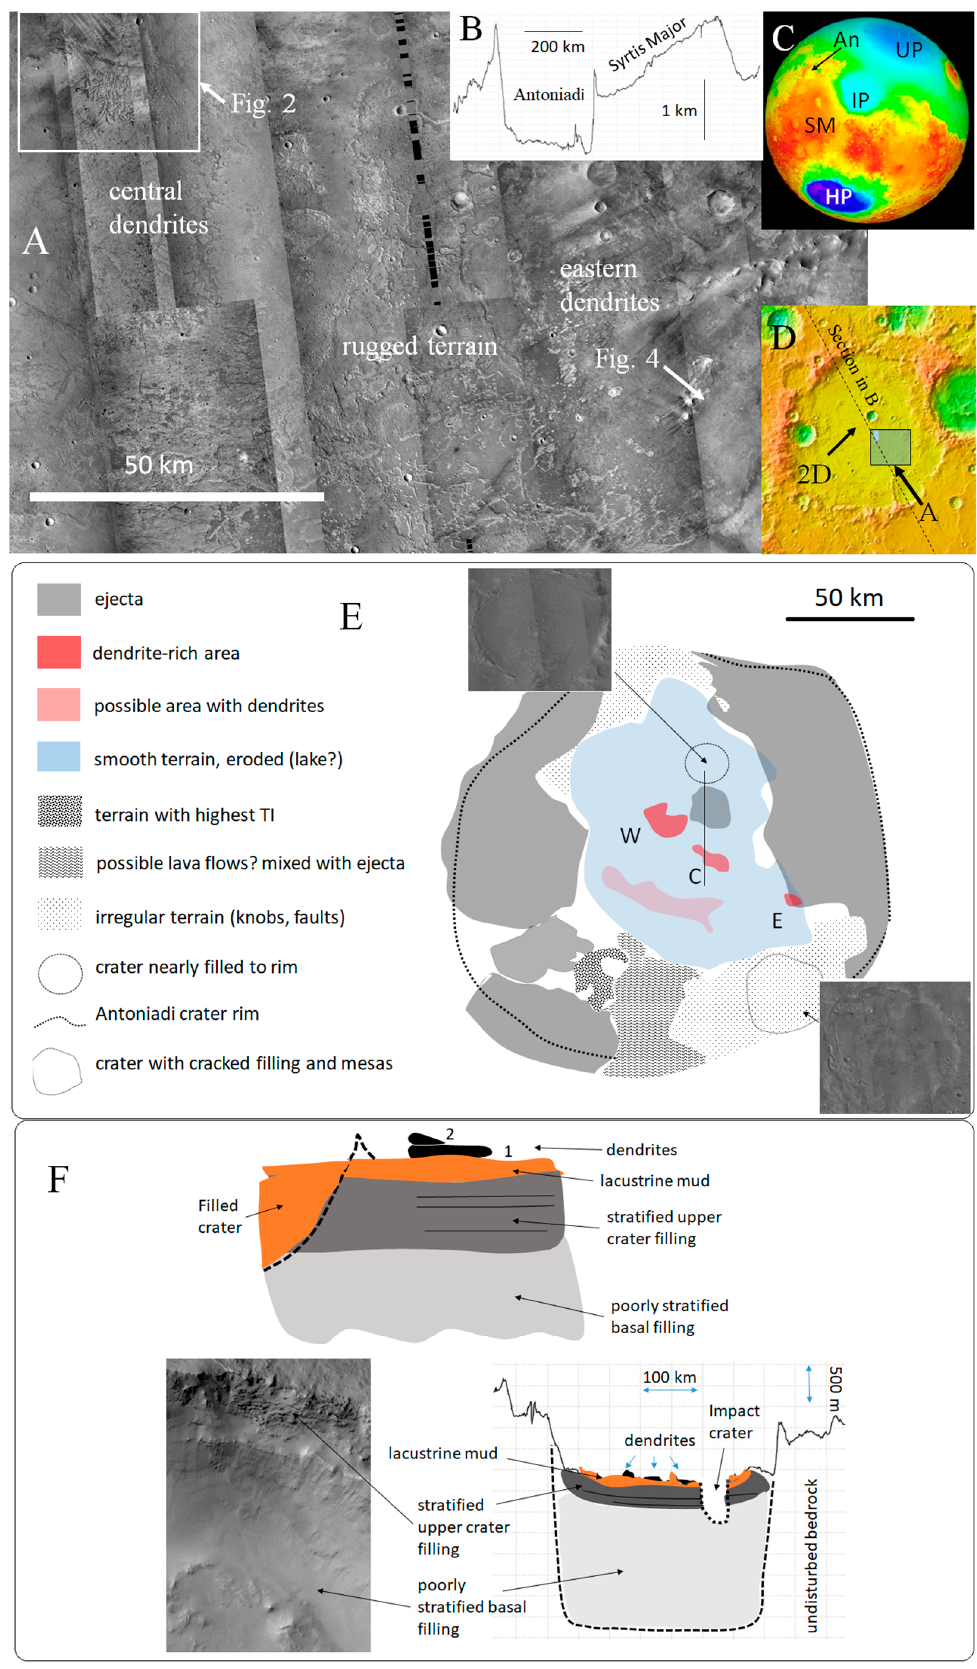
Figure 1. The Antoniadi crater. ( A ) The roughness of the crater floor is evident in this CTX